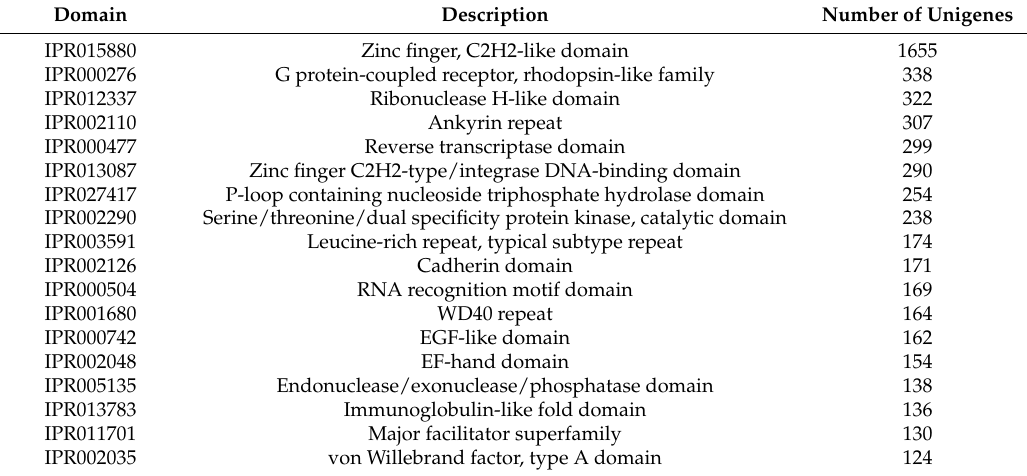
Table 3. Top hit InterPro terms from the InterProScan annotations of A. chejuensis unigenes. Domain